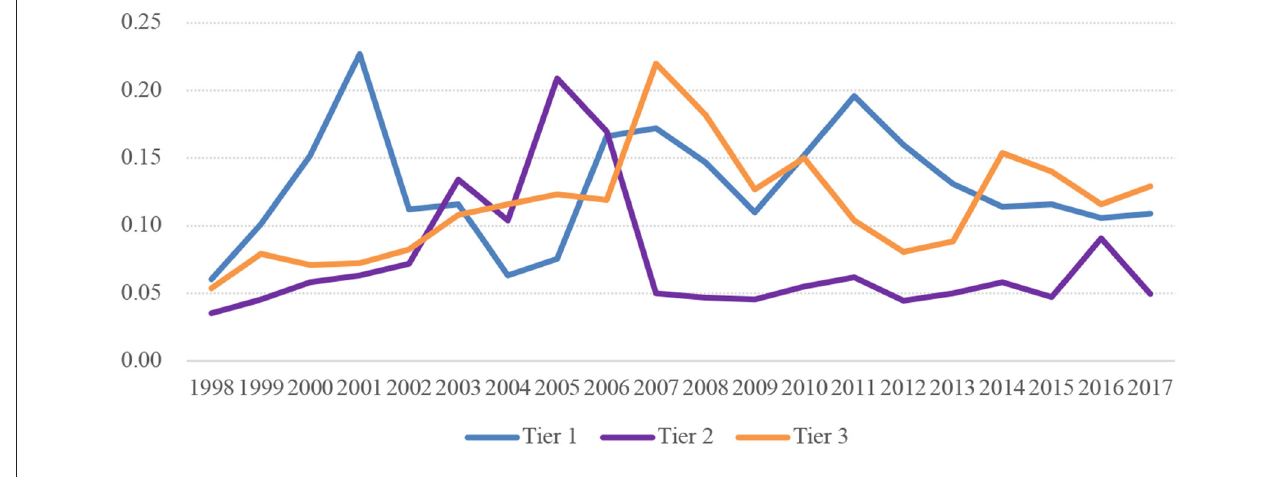
FIGURE 4 | Gini coefficient of funding per student in HPIs of three tiers in China.